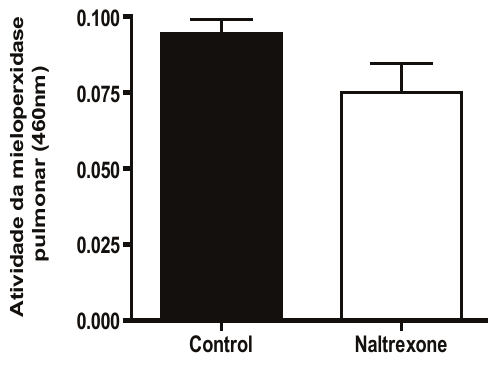
FIGURE 3 - Pulmonary myeloperoxidase activity. AP was induced in rats by intraductal injection of 0.5ml of 2.5% taurocholic acid. Control group received saline solution administration 15 minutes before AP induction and Naltrexone group received naltrexone (15mg/Kg) 15 minutes before AP induction. Data are expressed as mean ± SEM of nine animals per